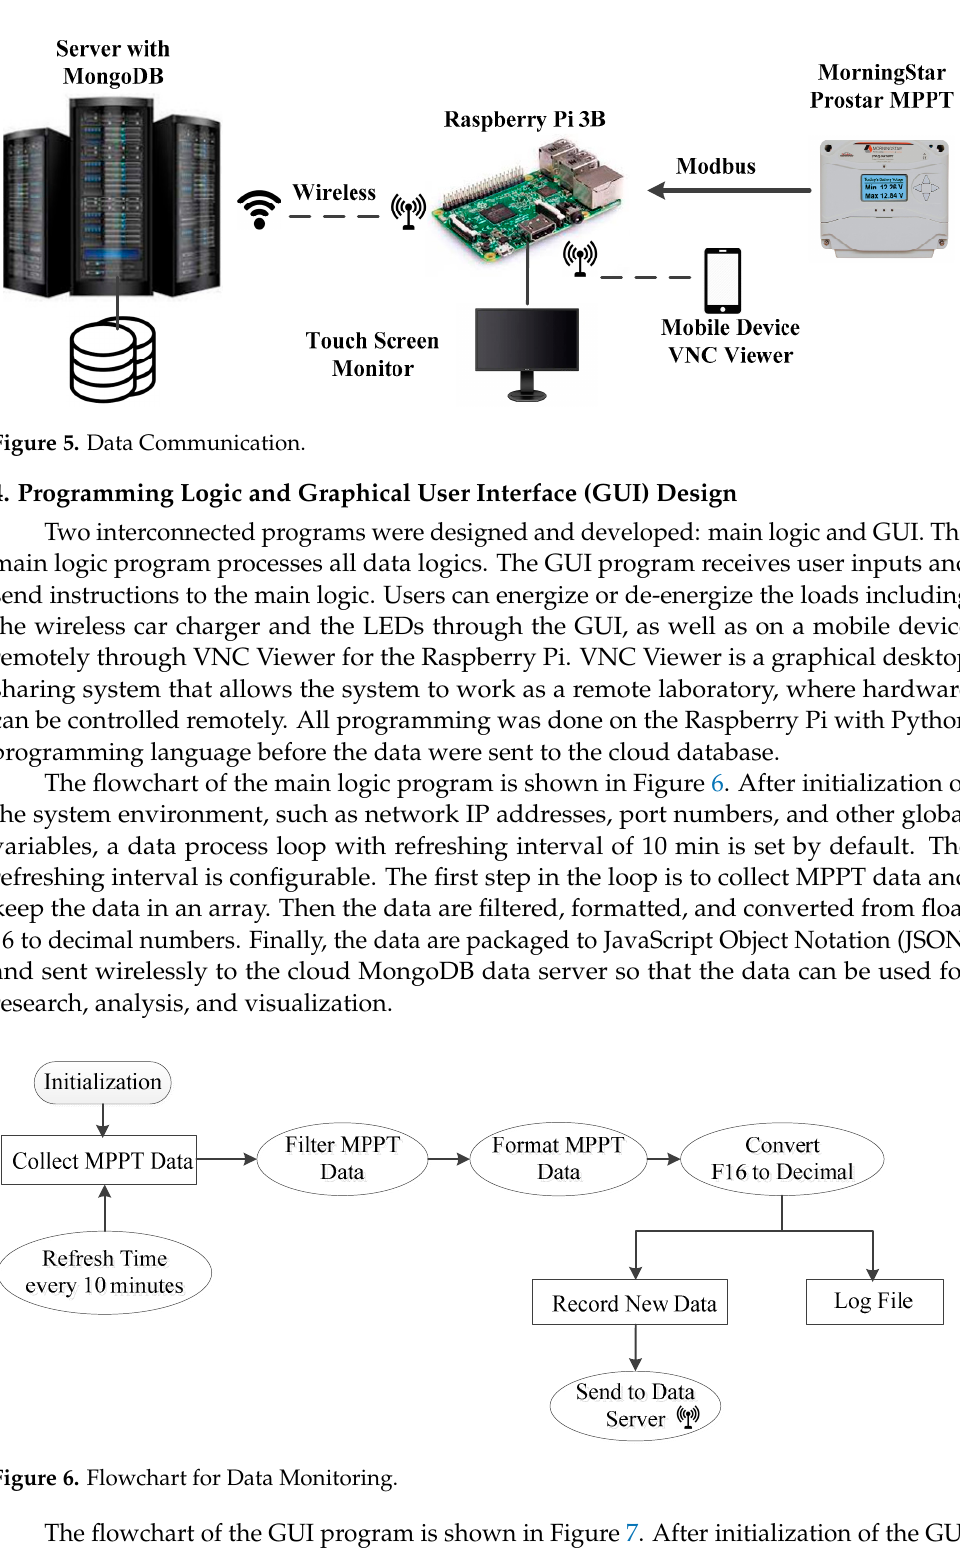
Figure 6. Flowchart for Data Monitoring.